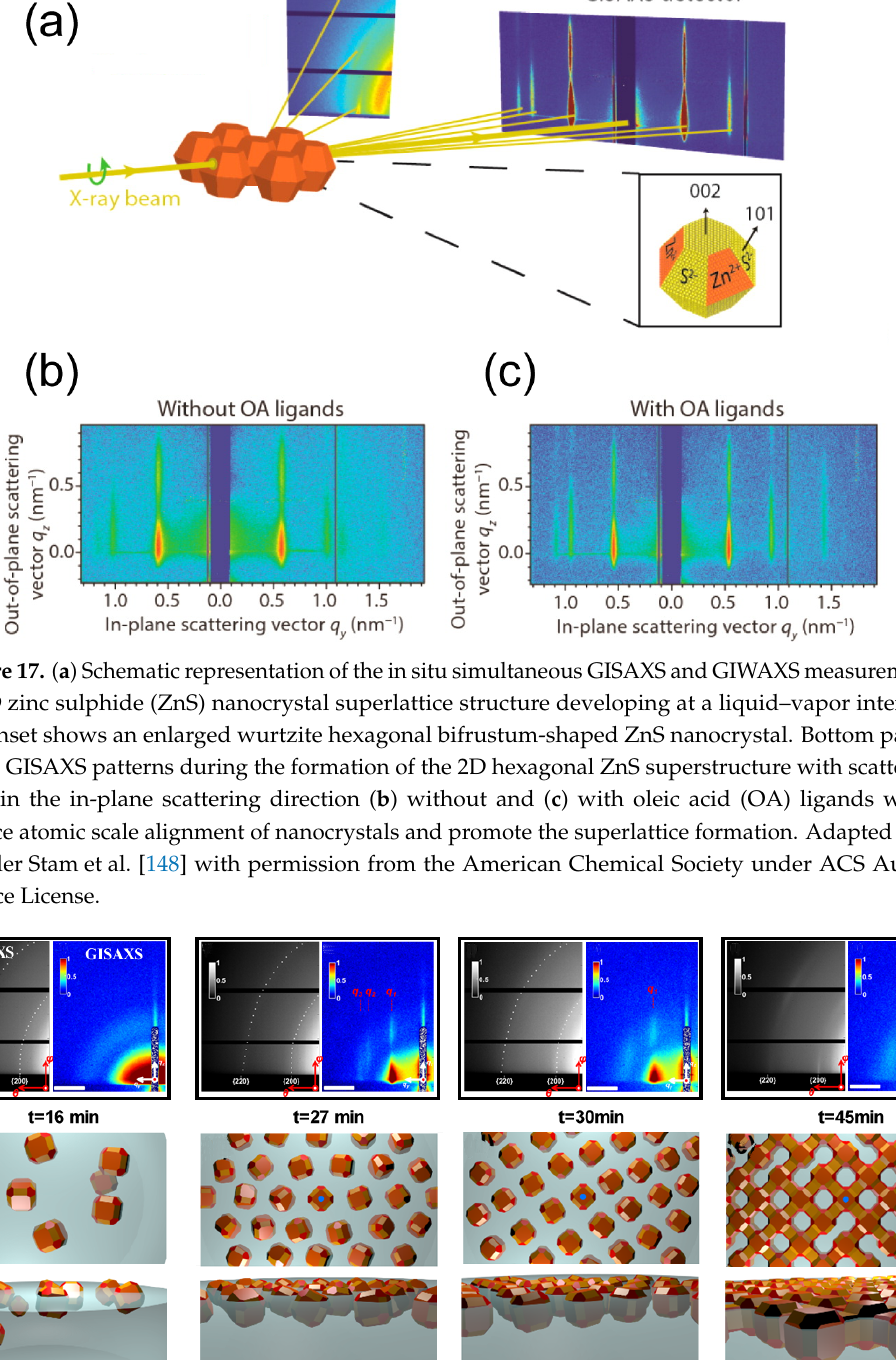
Springer (cid:13)